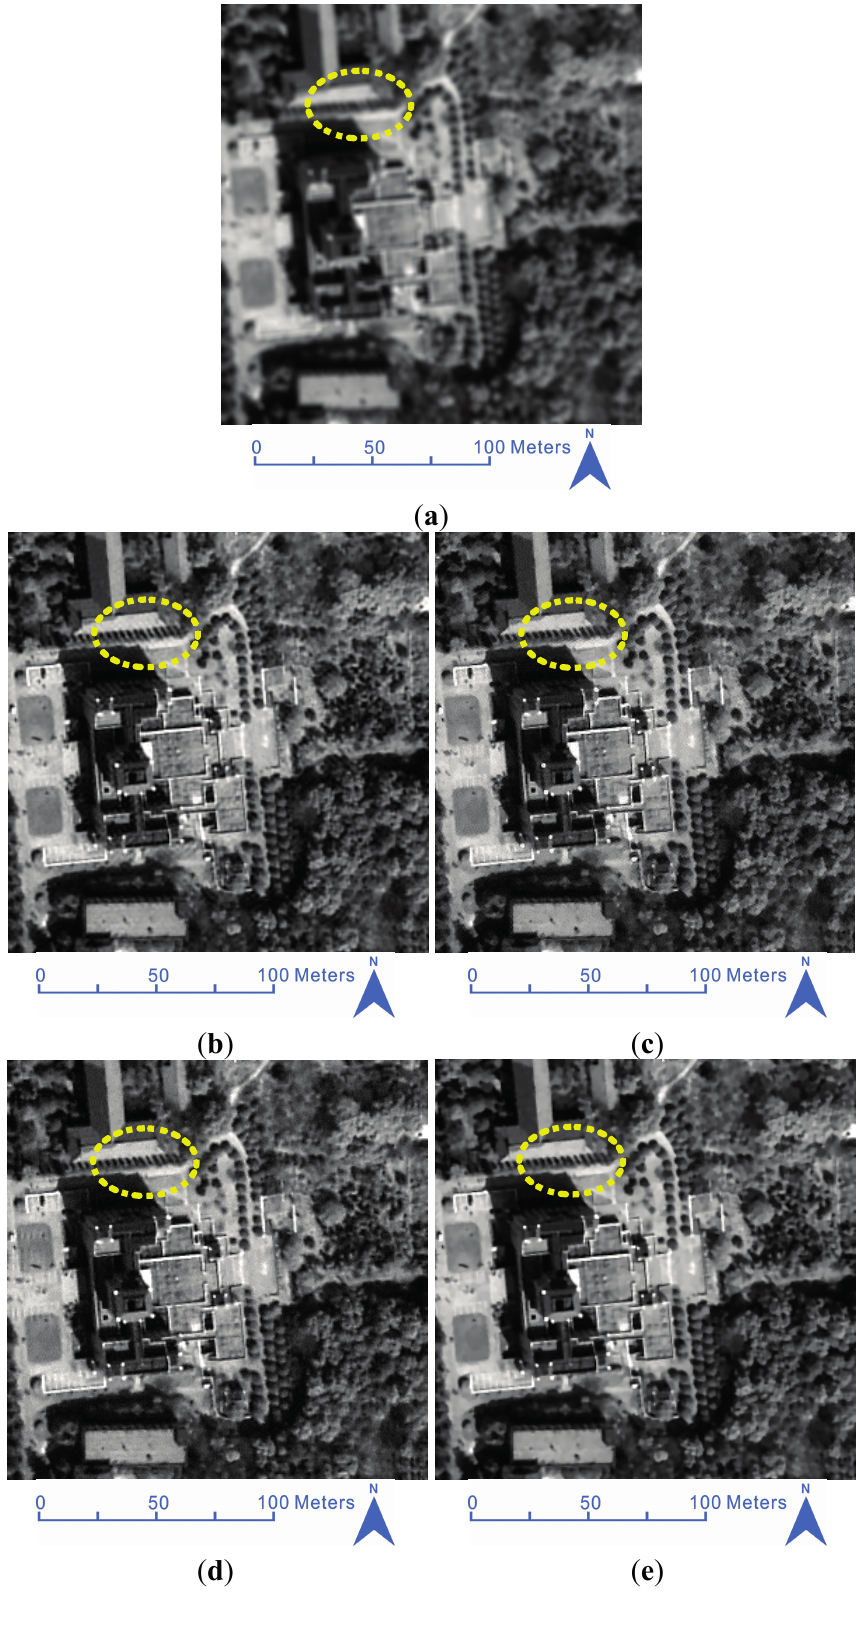
Figure 5. Comparison of the results for the QuickBird image in the noise-free case: ( a ) degraded image by a 5 × 5 truncated Gaussian PSF; ( b ) restored image of the MLO method; ( c ) restored image of the AM-Sparse method; ( d ) restored image of the AM-HMRF method; ( e ) restored image of the AM-KEdge